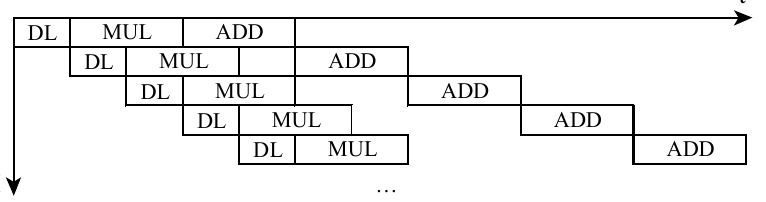
Figure 6. The pipeline of inner product unit of Convolution Layers.